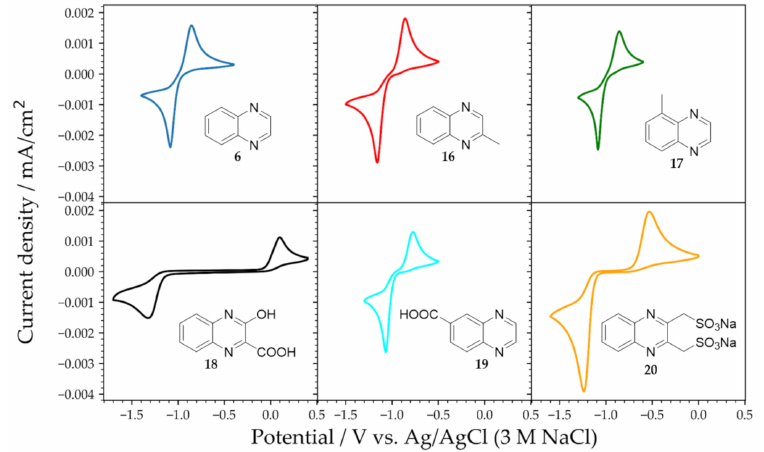
Figure 5. Cyclic voltammetry of 5 mM solutions of quinoxalines 6 , 16 – 20 dissolved in 0.1 M KOH/0.9 M KCl. The voltammograms were recorded at a scan rate of 100 mV/s using a 3 mm diameter glassy carbon disk electrode.